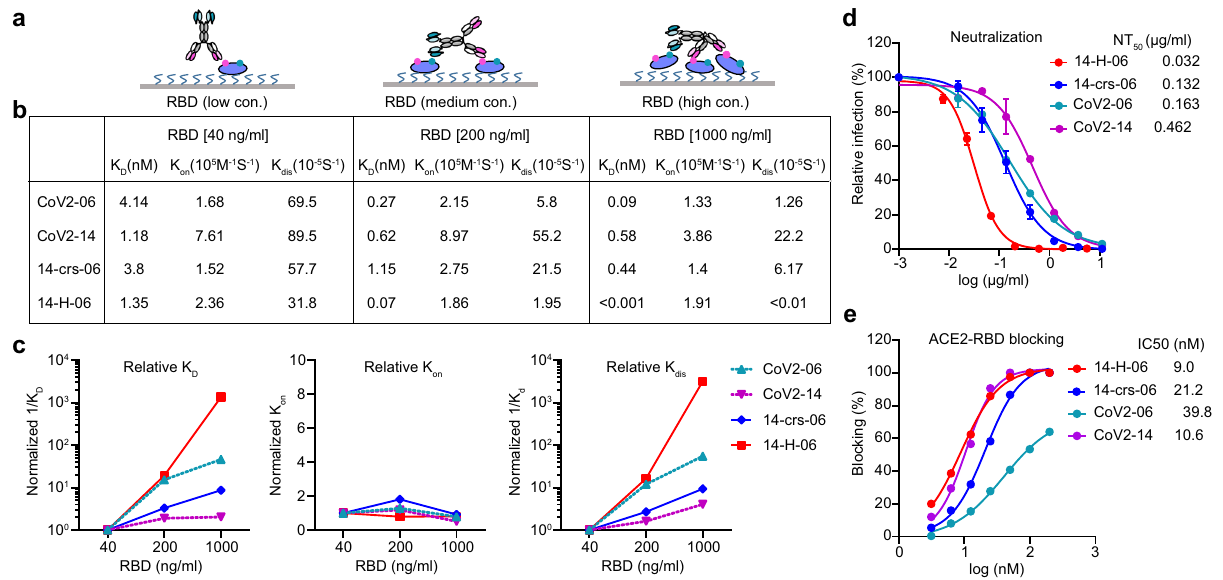
association, dissociationand avidityforeachantibody.Therelativevaluesforeach antibody were obtained by normalizing the values of 1/K D , K on and 1/K dis at RBD concentrations of 200ng/ml and 1000ng/ml against the corresponding values at RBD concentration of 40ng/ml. d Neutralization titrations of indicated antibodies against live SARS-CoV-2 on Vero E6 cell. Data points are from duplicate wells. e Antibody blocking of RBD interaction with ACE2 determined by the BLI